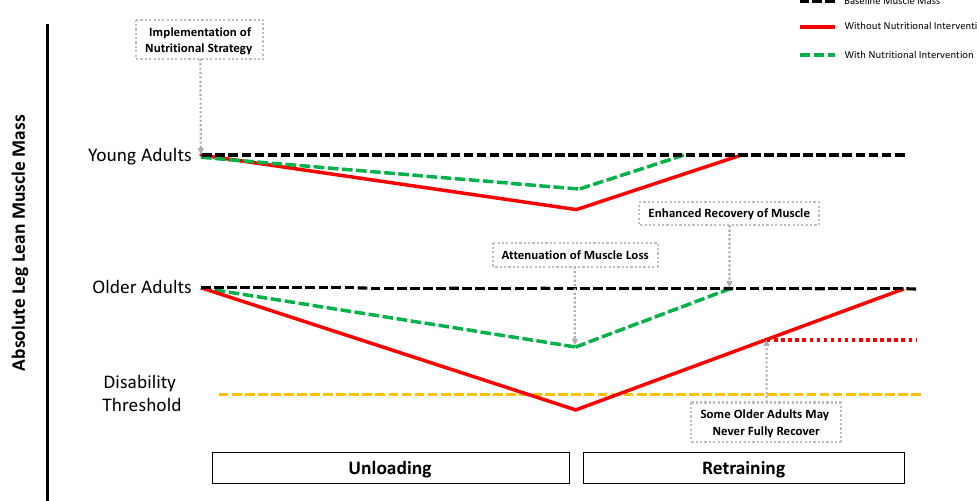
Figure 1. Skeletal muscle atrophy younger and older adults in response to a period of unloading and a subsequent period of exercise rehabilitation. The black dotted lines indicate phenotypical di ff erences in absolute levels of muscle mass. The yellow dotted line indicates a level in which low levels of leg lean mass results in disability and reduced functional ability (i.e., disability threshold). The red line indicates traditional trajectory in loss of muscle mass observed by disuse. The green dotted line indicates